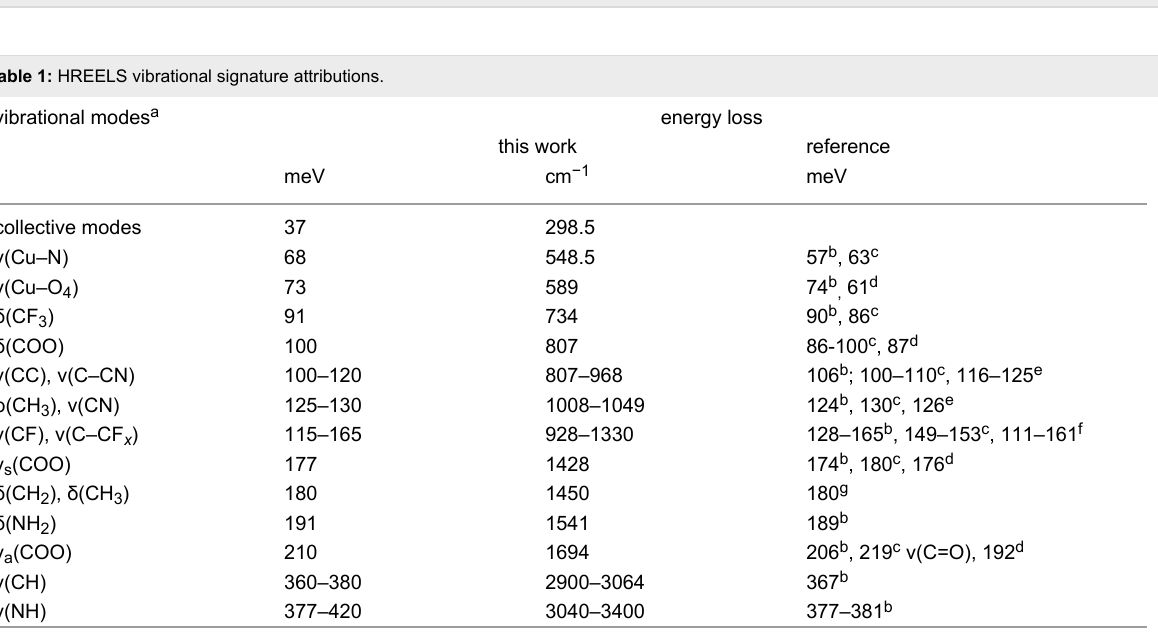
Figure 2: Vibrational signatures of compound A and B in different environments. (a, brown curve): ATR-IR spectrum of compound A as produced in Poland; (b, cyan curve): ATR-IR spectrum of compound A in France; (c, magenta curve): ATR-IR spectrum of compound B as produced in Poland; (d, orange curve) ATR-IR spectrum of compound B in France; (e, blue curve): ATR-IR of compound B on Si deposited by dip-coating; (f, green curve): HREELS spectrum of compound B deposited in gel form on gold, recorded at 30 K; (g, black curve): same as (f), after a mild annealing to 305 K.